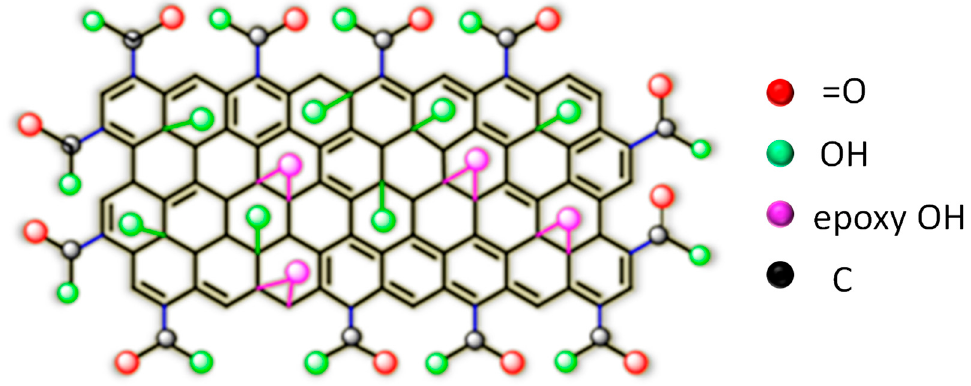
Figure 17. Lerf–Klinowski model of GO.